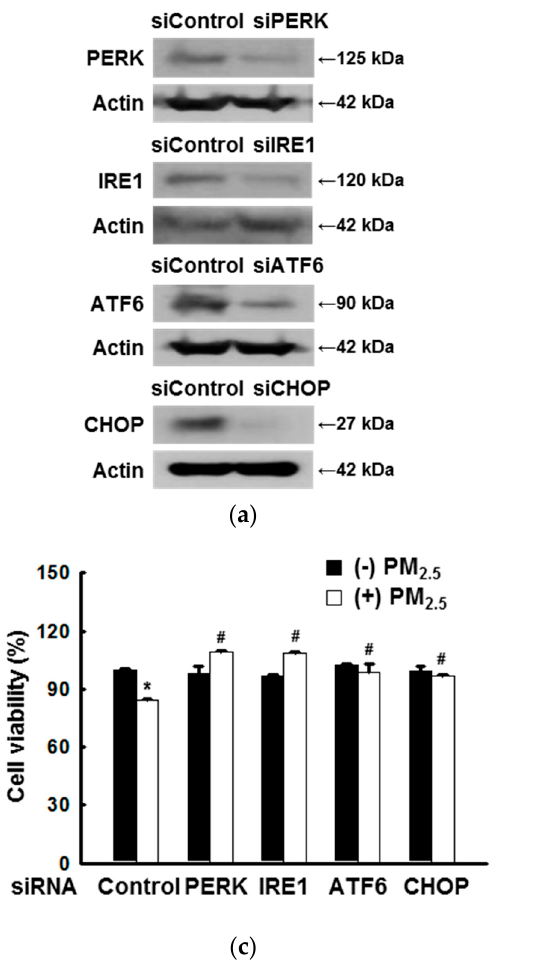
Figure 1. Endoplasmic reticulum (ER) stress mediates apoptosis after exposure to particulate matter 2.5 (PM 2.5 ). ( a ) HaCaT cells were transfected with control siRNA and siRNAs against PERK , IRE1 , ATF6 , and CHOP as verified by western blotting. The control, PERK, IRE1, ATF6, and CHOP siRNA-transfected cells were treated with PM 2.5 . ( b ) Nuclei were stained with Hoechst 33342 and images were acquired using a fluorescence microscope. Arrows indicate apoptotic cells. ( c ) Cell viability was assessed using MTT assay. ( b , c ) * p < 0.05 compared to siControl; # p < 0.05 compared to siControl + PM 2.5 .